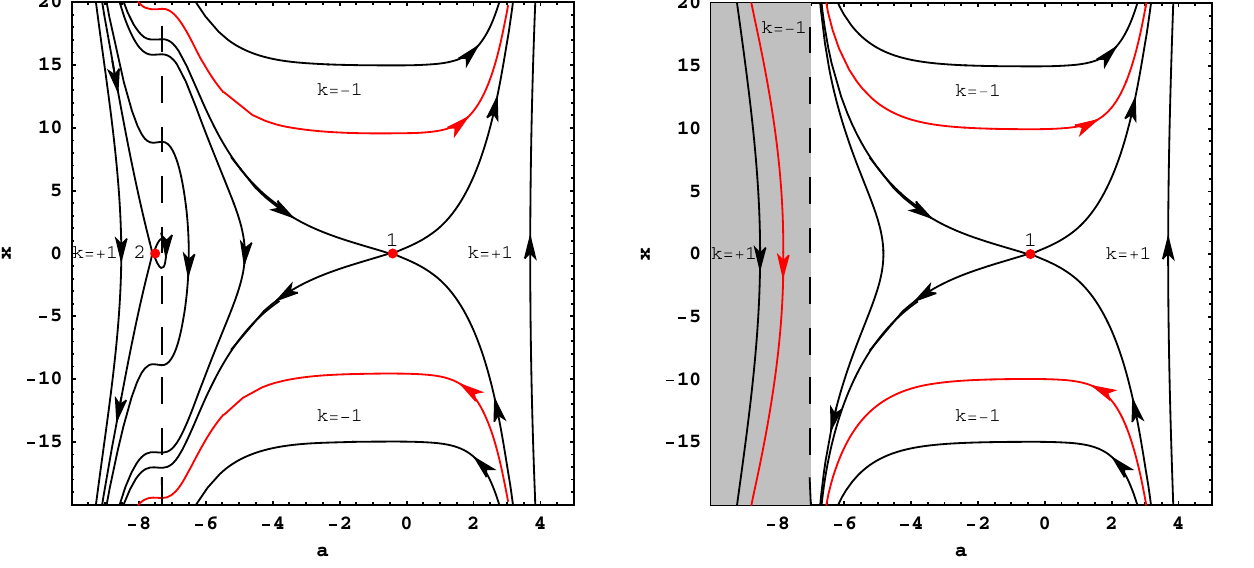
Fig. 13 The figure represents the phase portrait of the system (86–87) for positive (cid:3) γ . The scale factor a is in the logarithmic scale. The red trajectories represent the spatially flat universe. Trajectories under the top red trajectory and below the bottom red trajectory represent models with the negative spatial curvature. Trajectories between the top and bottom red trajectory represent models with the positive spatial curva- ture. The dashed line 2 b + d = 0 corresponds to the freeze singularity. The critical points (1) and (2) present two static Einstein universes. The phase portrait belongs to the class of sewn dynamical systems [49]